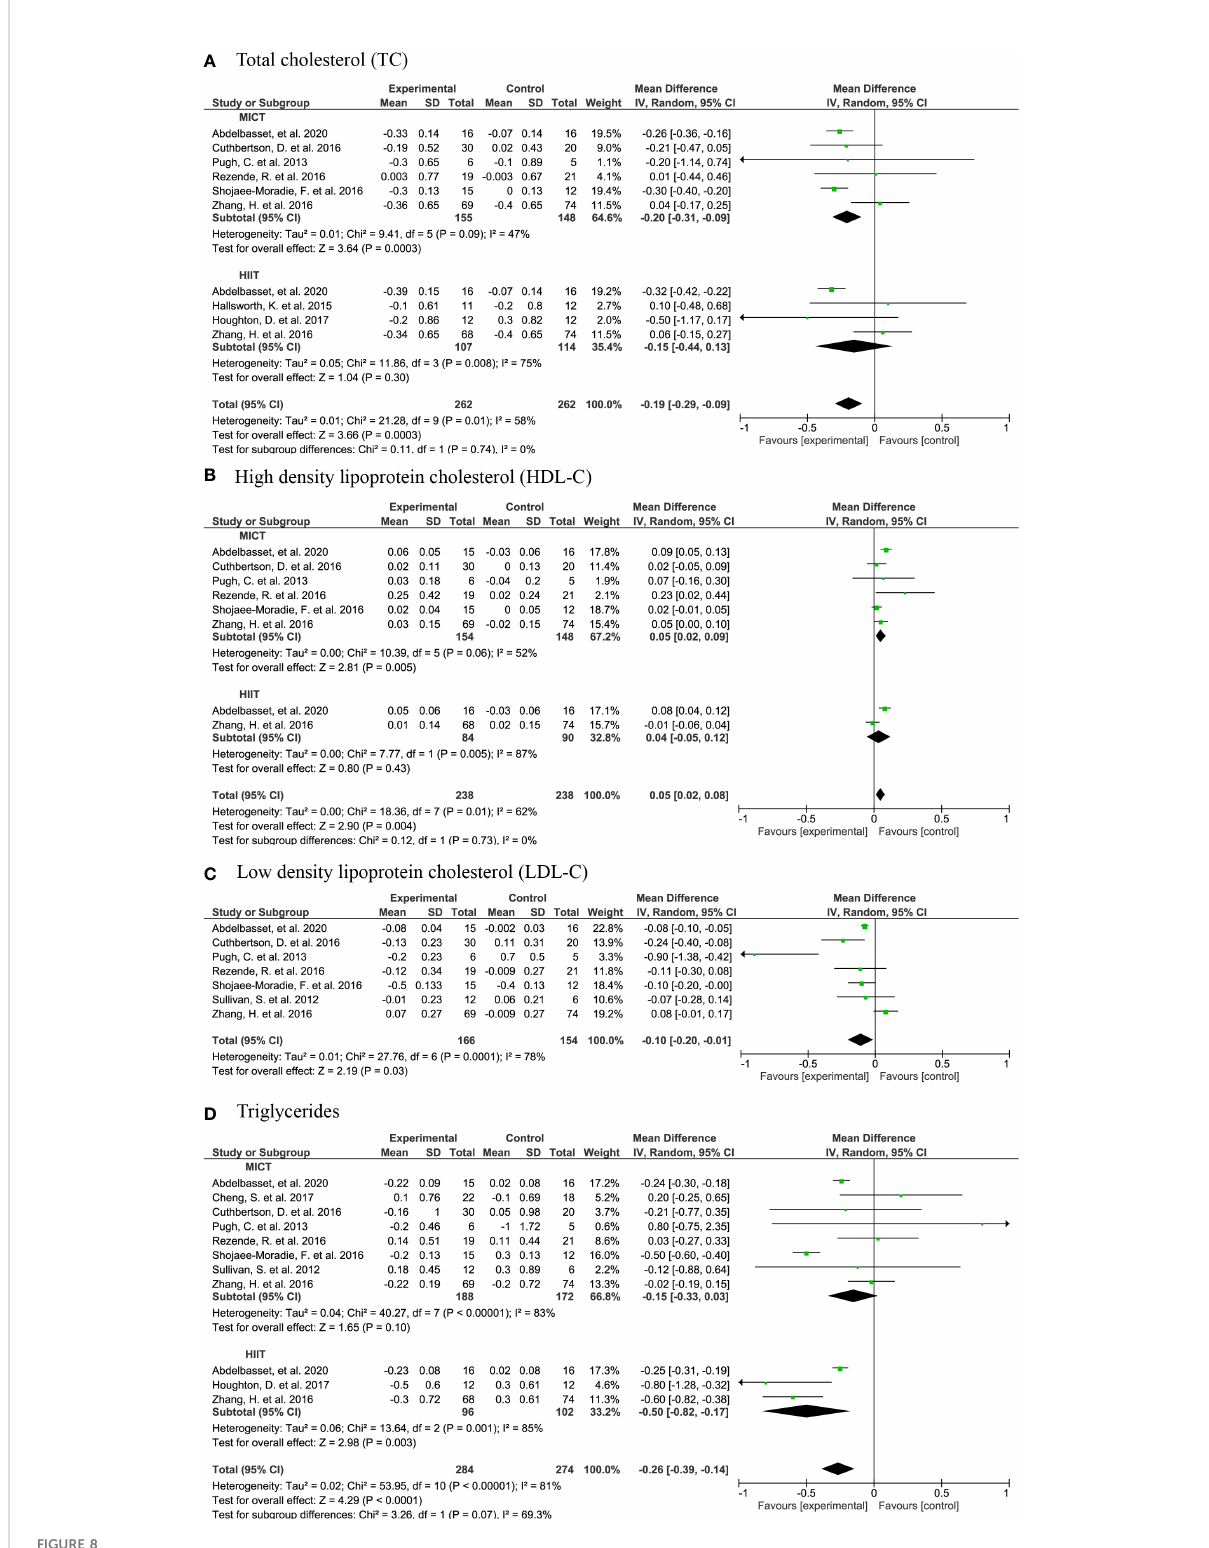
FIGURE 8 Forrest plot for the effect of moderate-intensity continuous training (MICT) and high-intensity interval training (HIIT) on plasma lipids: (A) total cholesterol (TC); (B) high-density lipoprotein cholesterol (HDL-C); (C) Forrest plot for the effect of MICT on low-density lipoprotein cholesterol (LDL-C); (D) triglycerides